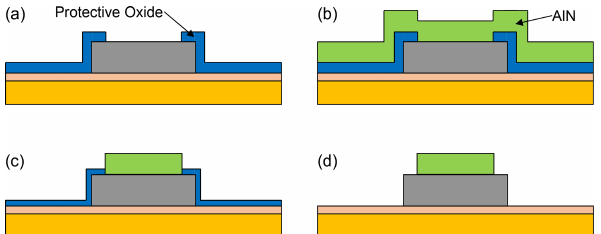
Figure 7. Schematic process flow to protect the polysilicon waveg- uides during subsequent dry-etching processes. (a) Deposition and structuring of a silicon oxide that should act as an protective layer. (b) Sputtering of AlN. (c) Structuring of the AlN layer by means of lithography and dry etching. During the over-etching sequence of the AlN etch, the protective oxide becomes thinner (sacrificed) but is not completely consumed. (d) Wet-chemical cleaning to remove the residuals of the sacrificial oxide. The AlN remains only at the structures that form the